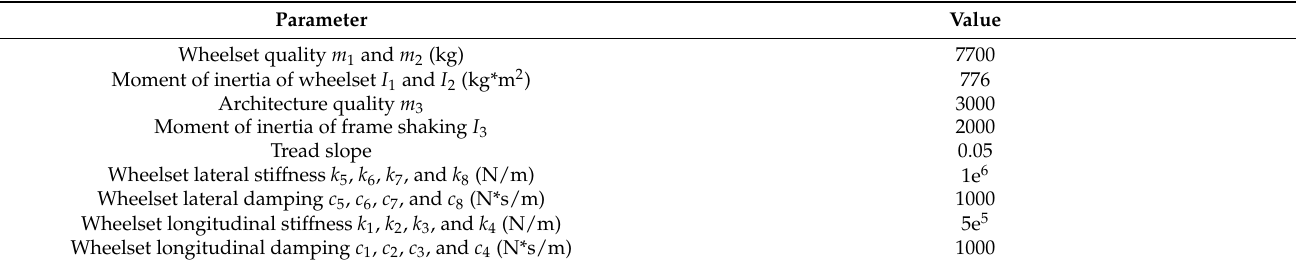
Table 8. Other parameters of the bogie.